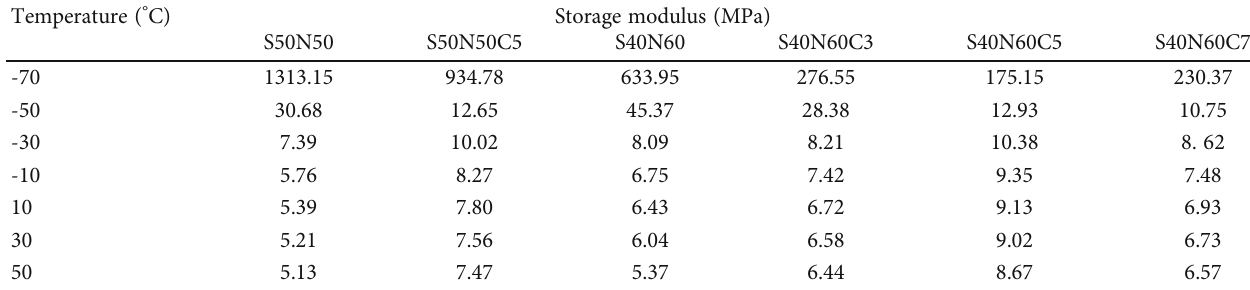
Table 6: Storage modulus of samples.